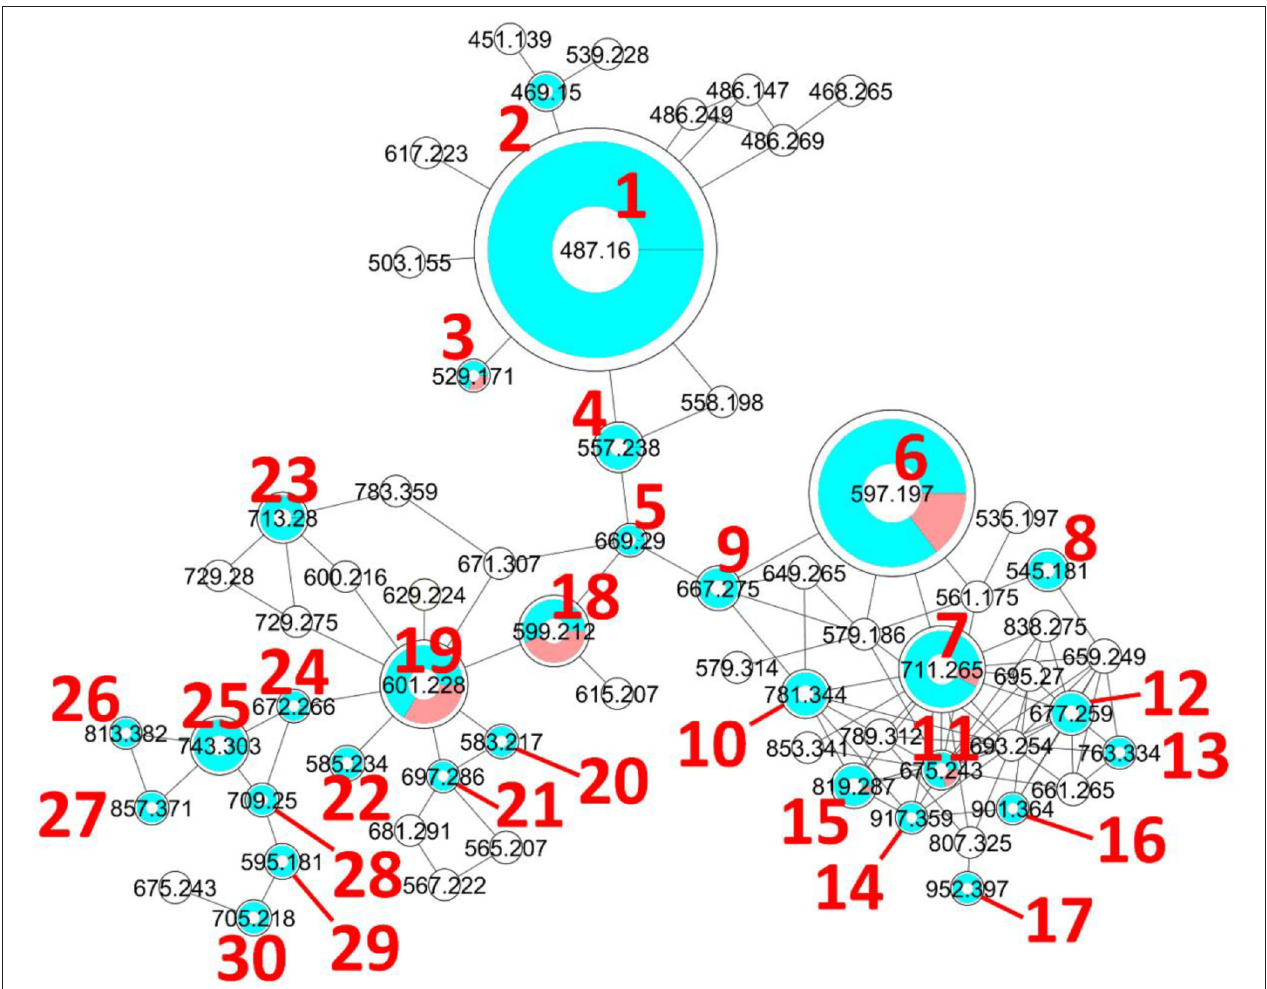
FIGURE 2 | Molecular network generated with the GNPS Molecular Networking tool. The diameter of the nodes represents the total extracted ion chromatogram integration of the corresponding ion peak(s) and the blue/red pie chart represents the proportions of each isomer in the cluster. The colorless nodes are clusters of MS 2 spectra of ions produced by in-source fragmentation of diverse compounds and were thus neither annotated nor integrated (integration was set to 0). Only protonated molecular ions were considered for integration